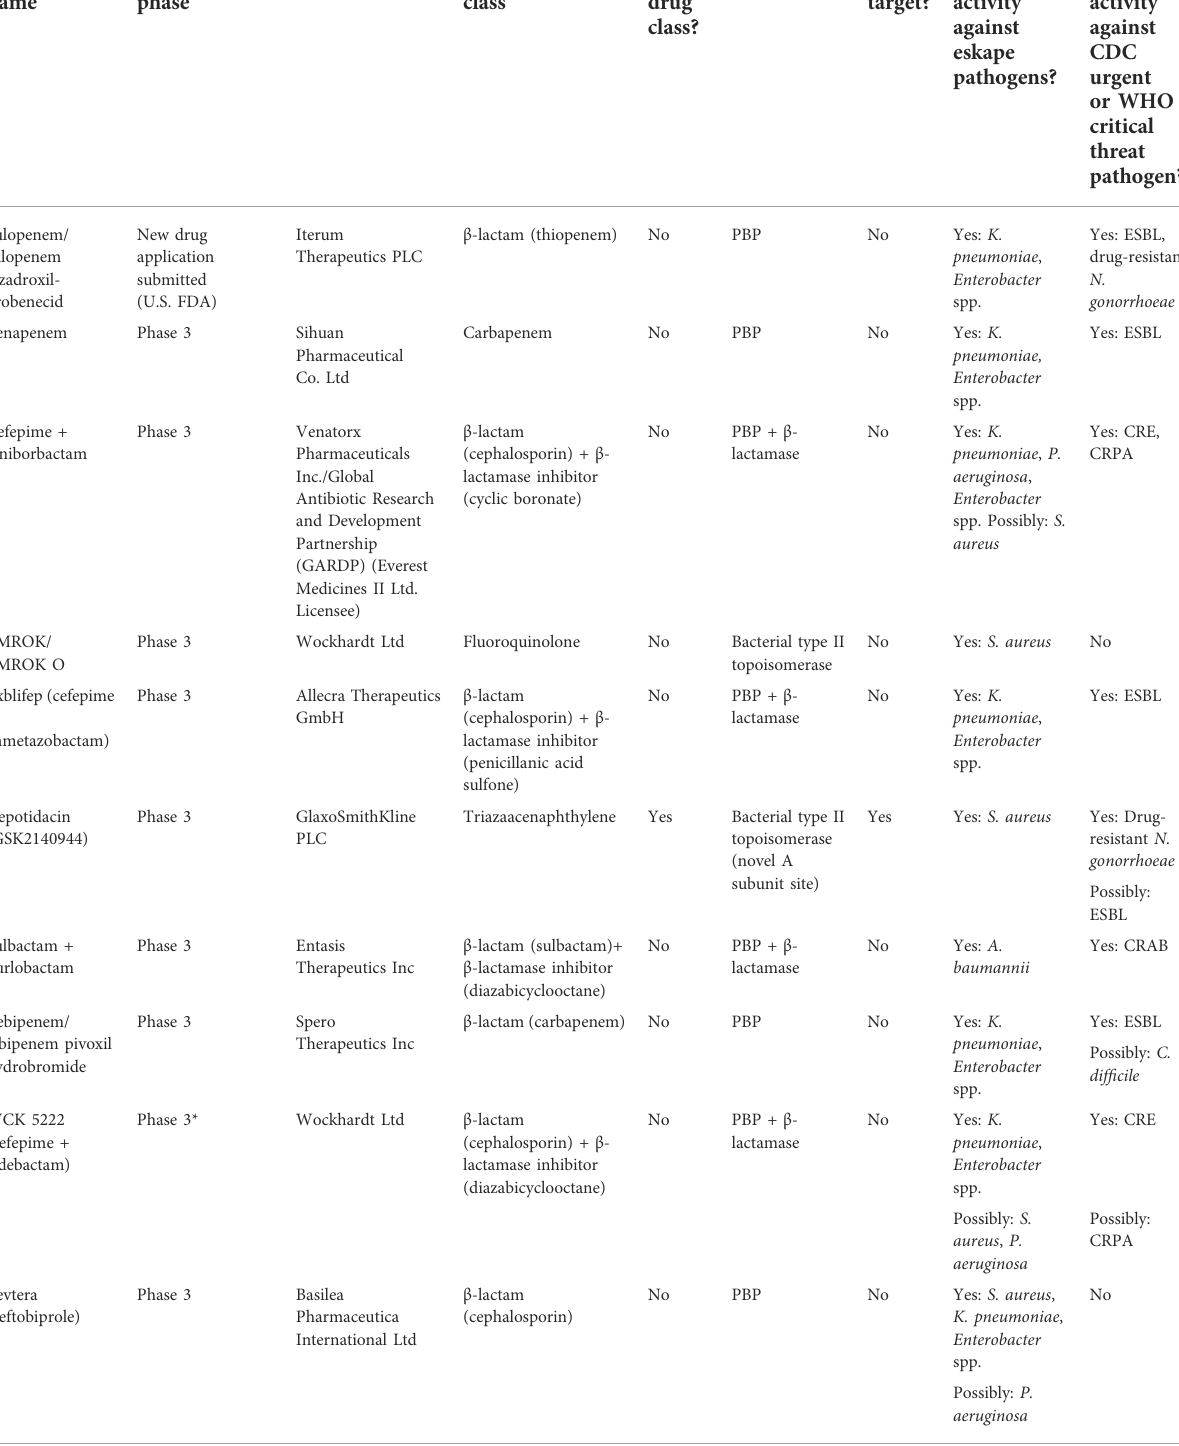
TABLE 1 Antibiotics currently in global clinical development. Abbreviations: PBP, penicillin-binding protein; ESBL, extended-spectrum beta- lactamase;CRE,carbapenem-resistantEnterobacterales;CRPA,carbapenem-resistant P.aeruginosa ;CRAB,carbapenem-resistant A.baumannii